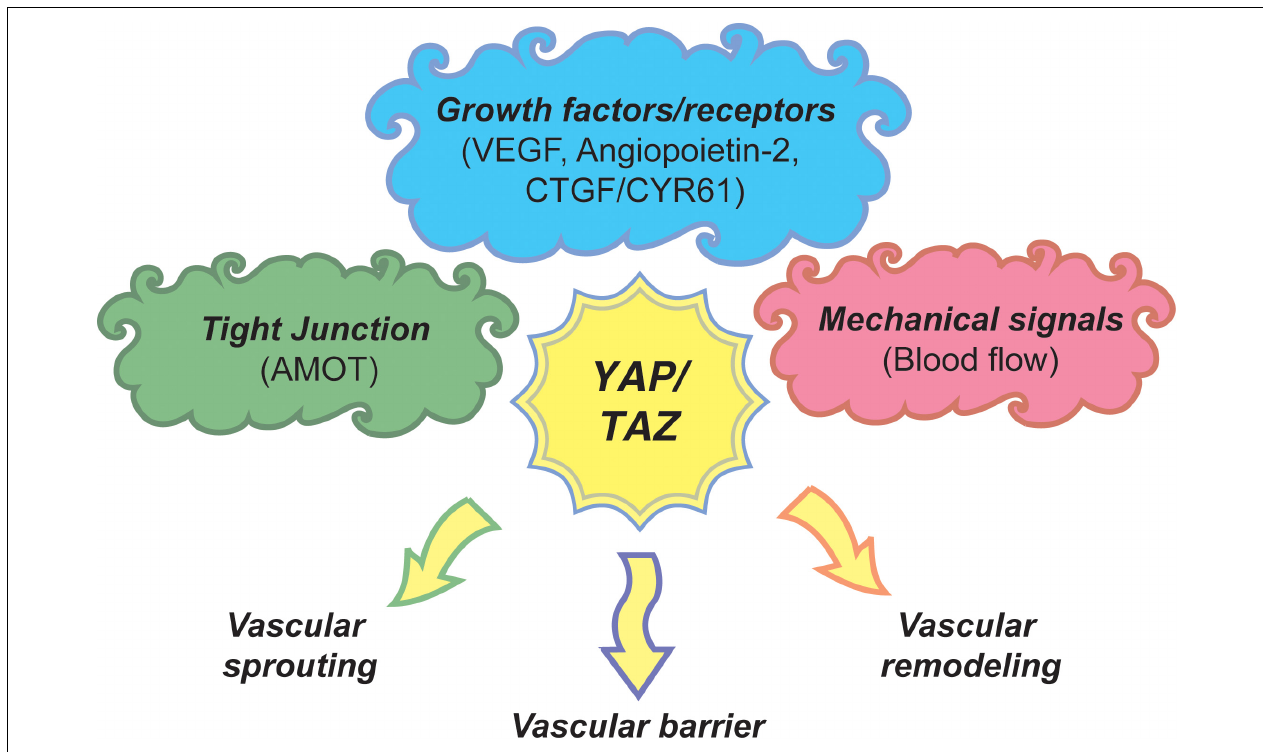
FIGURE 3 | A model of Hippo pathway-YAP/TAZ angiogenic program. Upstream signaling cues such as tight junction proteins, growth factors/receptors and mechanical signals regulate the activity of YAP/TAZ through Hippo pathway or independent mechanisms to regulate endothelial cell proliferation, migration and survival subsequently regulating vascular sprouting, vascular barrier formation, and vascular